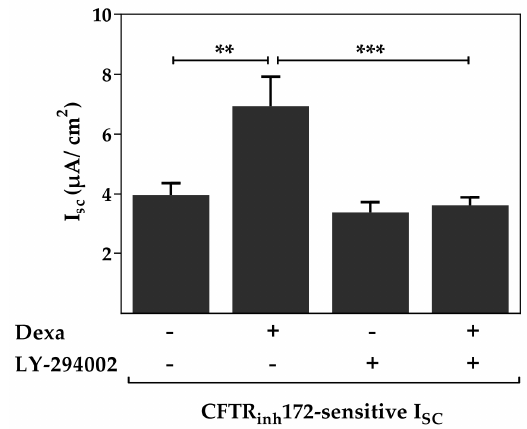
Figure 1. Phosphoinositide 3-kinase (PI3K) contributes to the increased cystic fibrosis transmembrane conductance regulator (CFTR) activity induced by dexa. Primary airway epithelial cells were treated with 100 nM dexa and LY-294002 (10 µM) for 24 h. Data bars represent mean + standard error of the mean (SEM) of I SC . Dexa increased the CFTR inh 172-sensitive I SC . Addition of LY-294002 prevented the dexa-induced increase of CFTR activity ( n = 20–25, ** p < 0.01, *** p < 0.001, analysis of variance (ANOVA) with Tukey’s post hoc test).